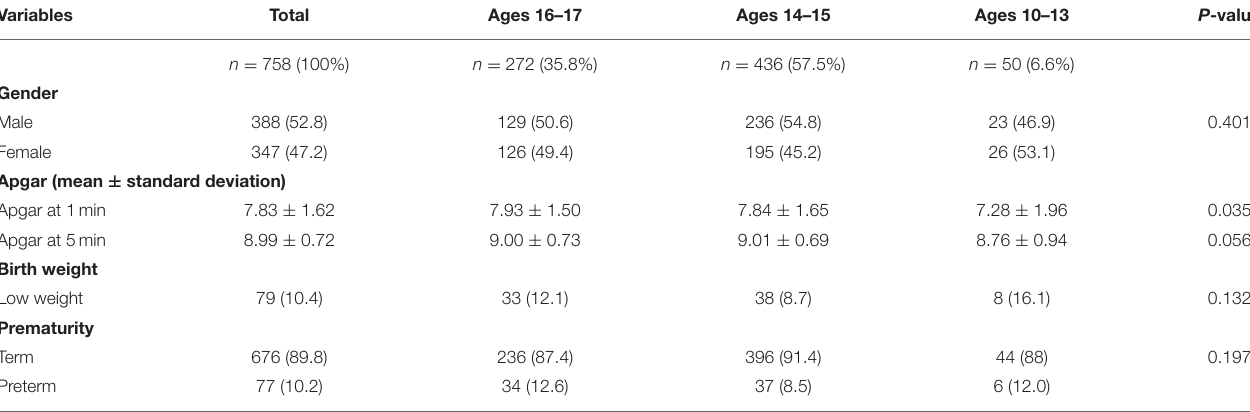
TABLE 2 | Characteristics of infants born to mothers who received prenatal care.